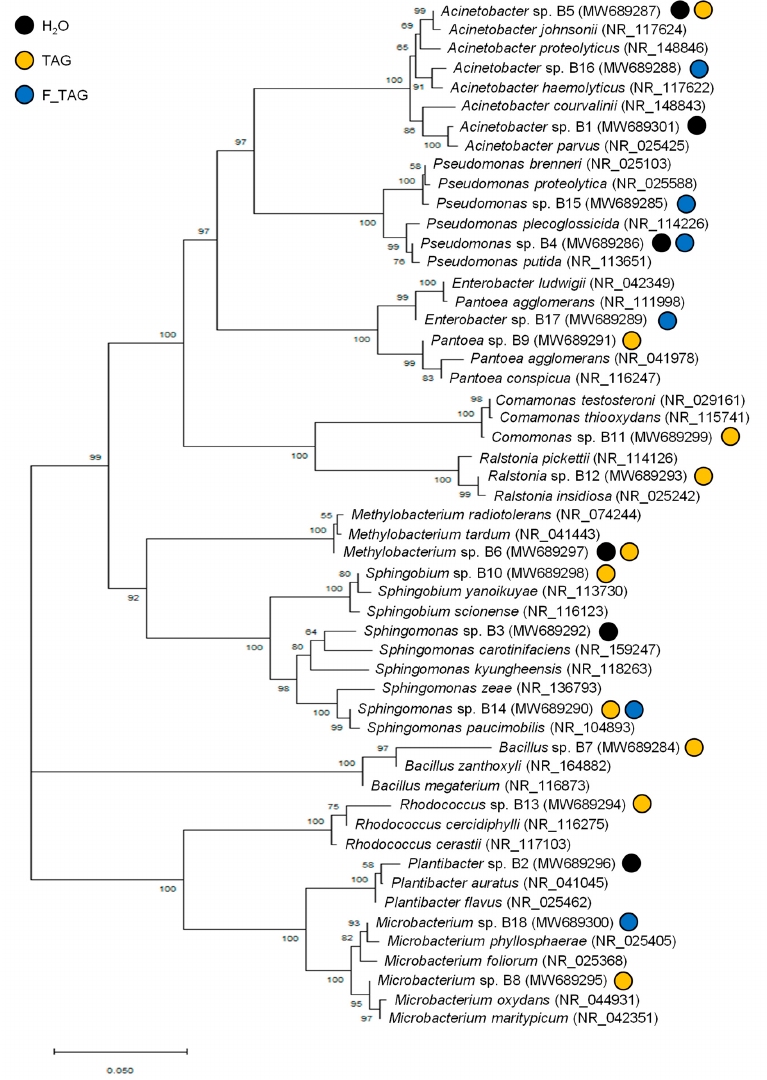
Figure 5. Neighbor-joining phylogenetic tree of potential tagatose-degrading bacteria. Bacterial isolates were obtained from leaf washing suspensions of tomato plants treated with water (H 2 O; black), 5 g/L pure tagatose (TAG; yellow), or a formulated product that contained 5 g/L tagatose (F_TAG; blue) by incubation on a minimal agar medium amended with 5 g/L tagatose as the carbon source (potential tagatose-degrading bacteria; Table 1). The analysis was conducted with Kimura’s two-parameter calculation model in MEGA version 6.0, using the two best BLAST hits of 16S rRNA gene sequences at NCBI. Bootstrap values out of 1000 replicates are shown at the nodes and the scale bar represents the number of substitutions per site.